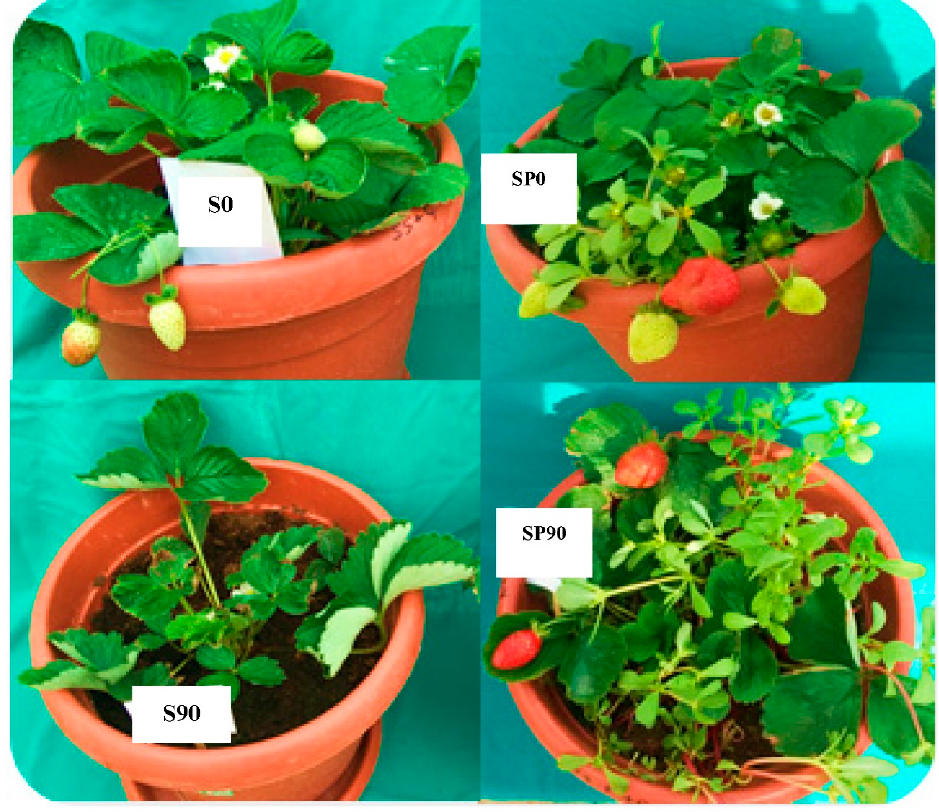
Figure 1. Strawberry plants were grown with or without Portulaca oleracea under different NaCl